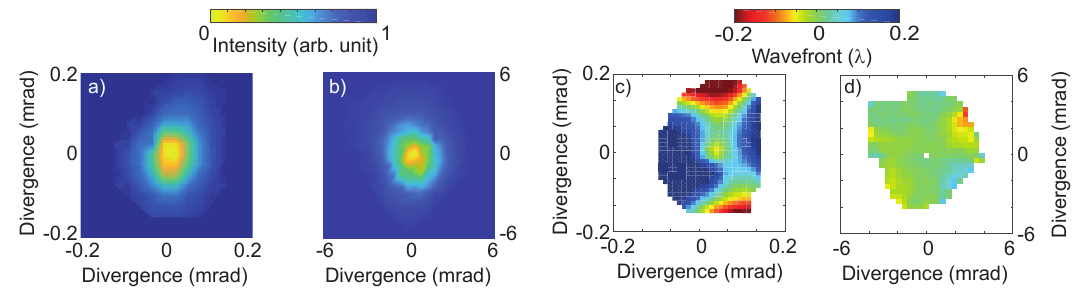
Figure 5. Intensity and wavefront of the XUV beam before ( a , c ) and after ( b , d )